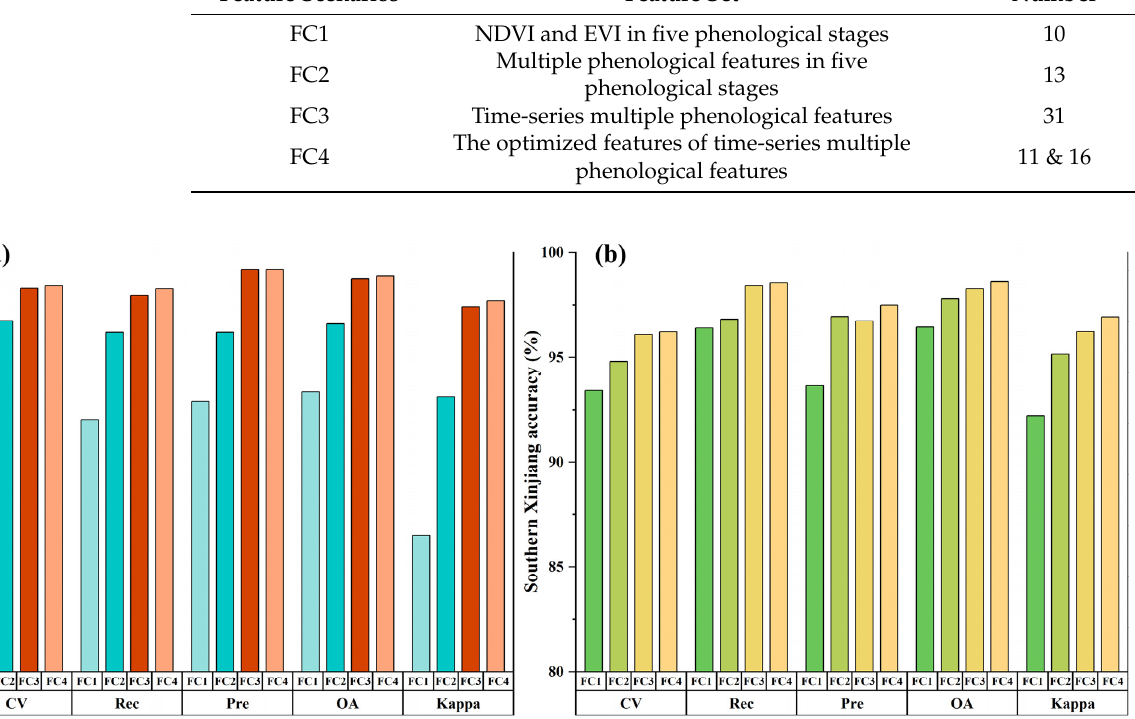
Figure 7. Multiple accuracy metrics for different feature scenarios. ( a ) represents northern Xinjiang. ( b ) represents southern Xinjiang.